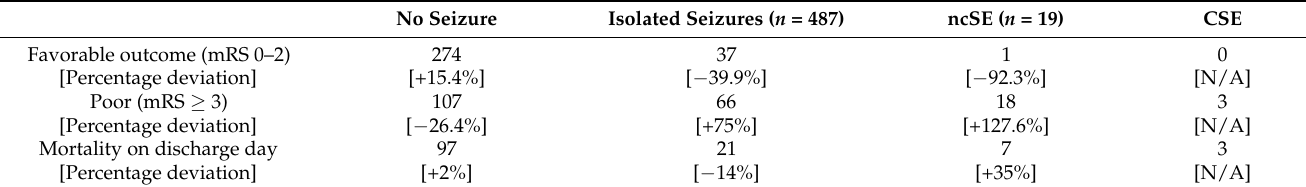
Table 3. Outcome stratified by absence of seizure, isolated seizure, ncSE and CSE.